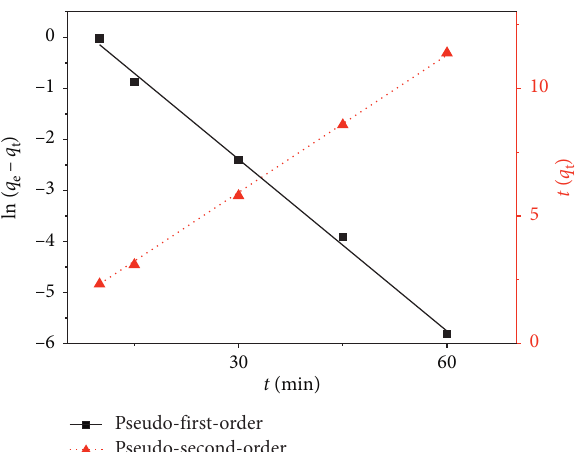
Figure 8: Linear fits of pseudo-first-order and pseudo-second-order kinetics for MO adsorption onto sugar scum powder ( C � 100mg/L; 0 adsorbent dose � 16g/L; pH � 7.21; T � 22 ° Table 1: Kinetic parameters for the MO adsorption onto sugar scum powder ( C � 100mg/L; adsorbent dose � 16g/L; pH � 7.21; T � 22 ° C). 0 Pseudo-first-order Pseudo-second-order q e,exp (mg/g)